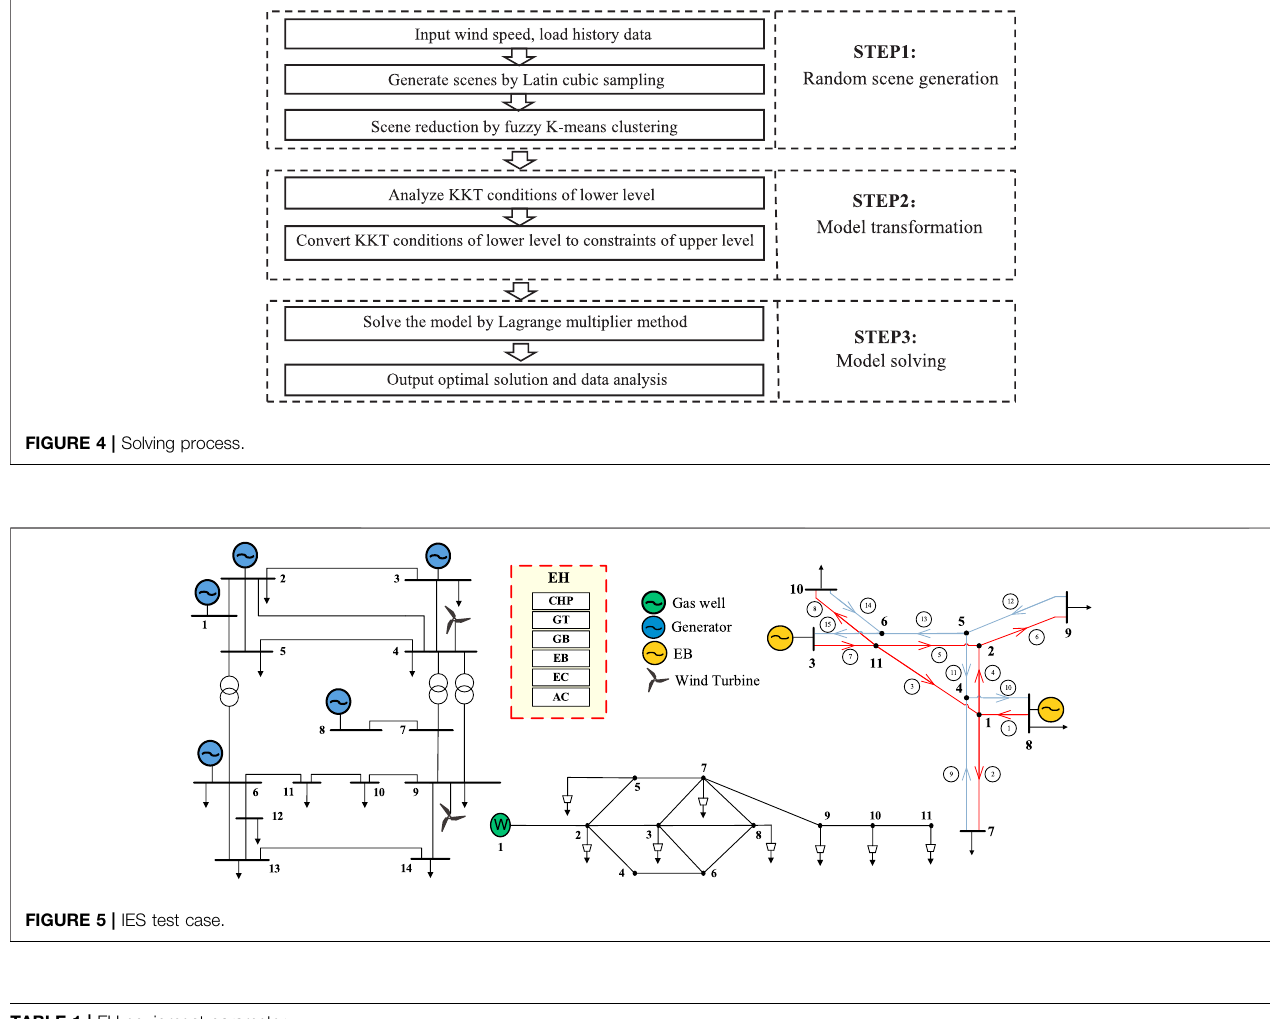
TABLE 1 | EH equipment